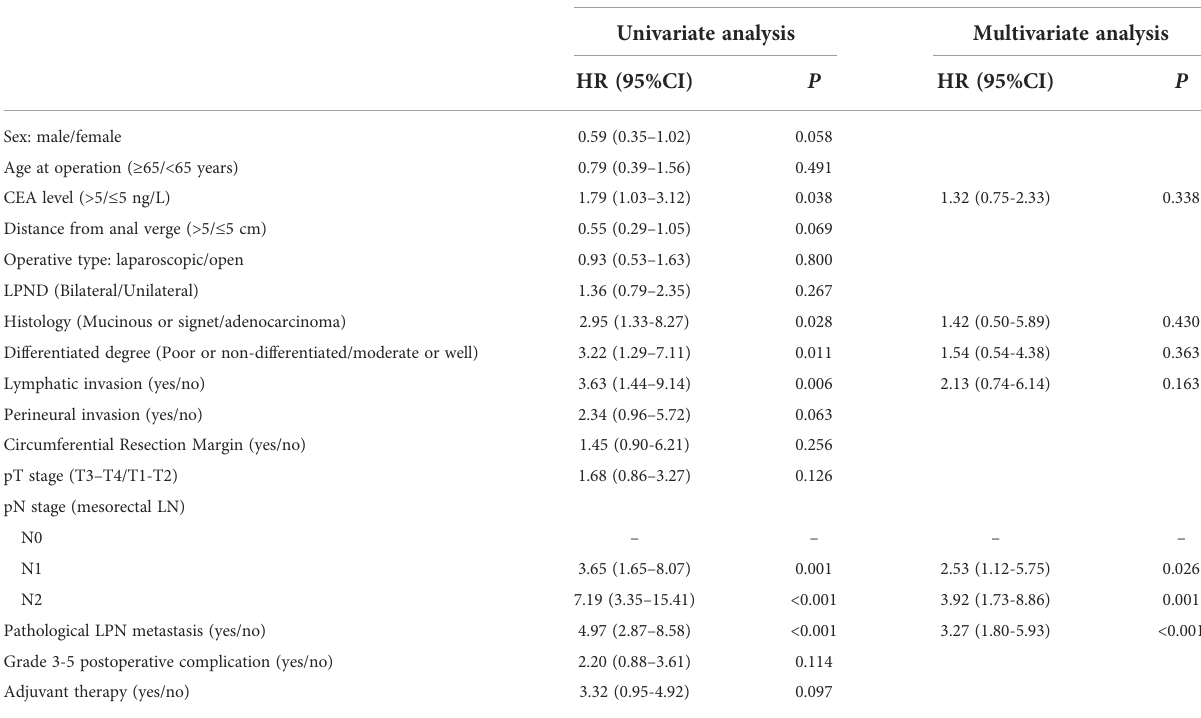
TABLE 2 Univariate and multivariate regression analyses of overall survival in 387 patients with clinical LPN metastasis who underwent TME+LPND. Variables Overall survival Univariate analysis Multivariate